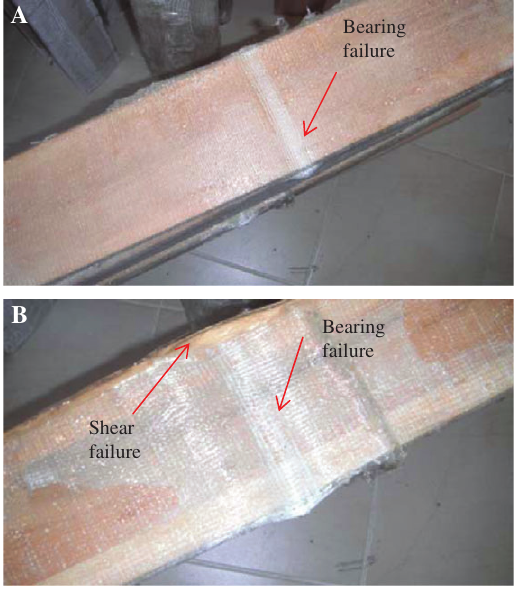
Figure 8 Photographs of failed Group A specimens. (A) I-shaped and (B) square hollow beams. failure mode for reinforced beams. Figure 9 shows observed failure in the Group B specimens with square hollow cross section. Compared to Group A specimens, the trace of the stress roller was less noticeable and the roller provided more uniform trace on top of the beam because the load was more uniformly distributed over the beam due to the fabric reinforcement (Figure 9A).